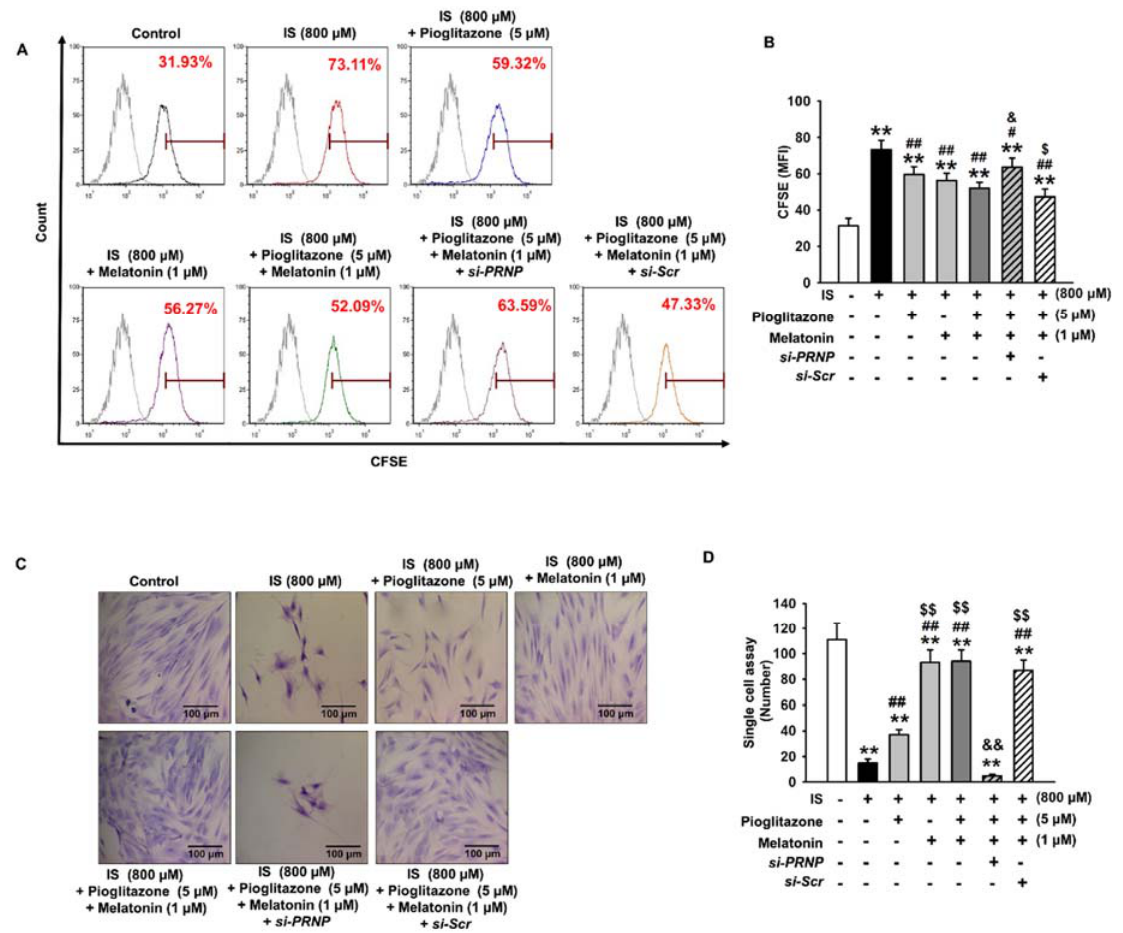
Figure 6. Pioglitazone and melatonin restore cell proliferation via PrP C . ( A ) Images of CFSE ‐ labeled MSCs and IS ‐ exposed MSCs treated with pioglitazone and melatonin or PRNP siRNA ‐ transfected MSCs; ( B ) FACS analysis of samples containing the dilution of CFSE in the same number of viable cells ( n = 3). The values represent the mean ± SEM; ** p < 0.01 vs. control, # p < 0.05 and ## p < 0.01 vs. IS only, $ p < 0.05 vs. pretreatment with pioglitazone or melatonin and IS, & p < 0.05 vs. pretreatment with pioglitazone and melatonin and IS (ANOVA, using Tukey’s post ‐ hoc test); ( C ) single ‐ cell cultures of IS ‐ exposed MSCs treated with pioglitazone and melatonin or PRNP siRNA ‐ transfected MSCs were stained with Giemsa after 10 days of growth. Scale bar = 100 μ m; ( D ) images of the number of cells per well in 96 ‐ well plates ( n = 3). The values represent the mean ± SEM; ** p < 0.01 vs. control, ## p < 0.01 vs. IS only, $$ p < 0.01 vs. pretreatment with pioglitazone or melatonin and IS, && p < 0.01 vs. pretreatment with pioglitazone and melatonin and treatment with IS (ANOVA, using Tukey’s post ‐ hoc test).